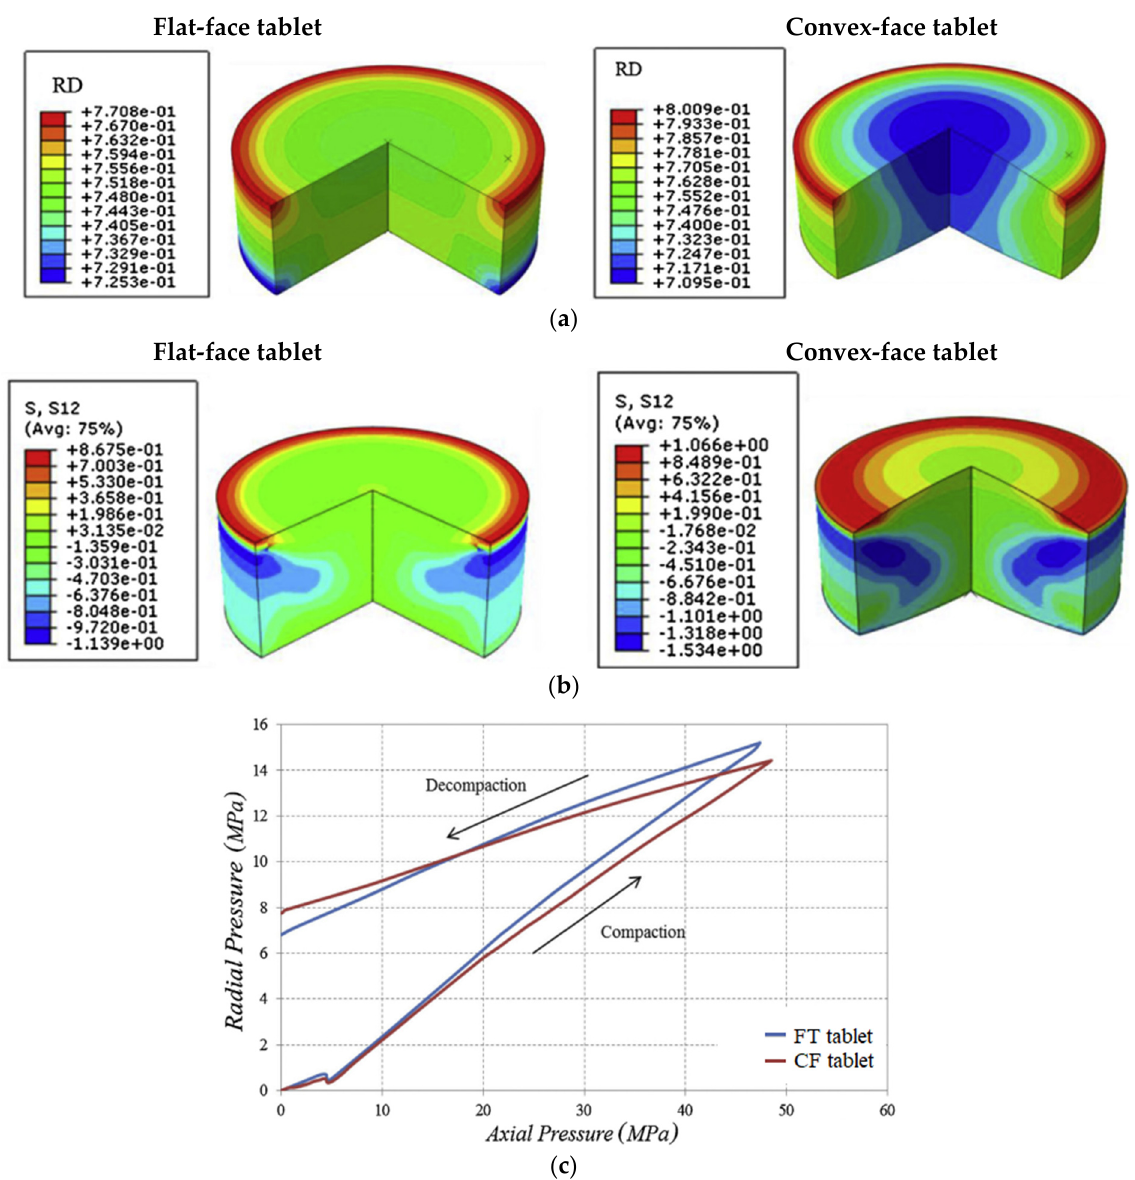
Figure 5. Comparison of flat- and optimal convex-faced tablets: ( a ) relative density (RD) distribution, ( b ) shear stress distribution within the tablets as they eject from the die, and ( c ) plot of radial pressure vs. compaction pressure (Adapted with permission from Ref. [96] ).